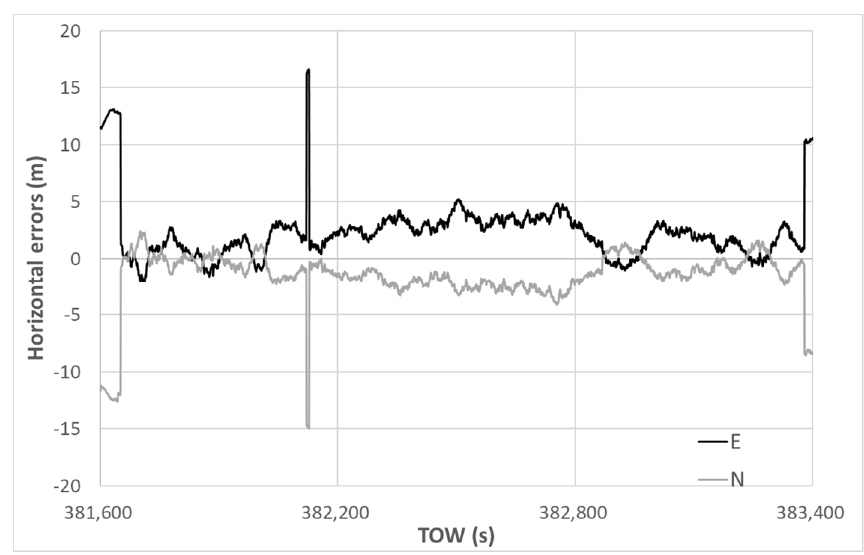
Figure 20 . DGNSS horizontal errors.